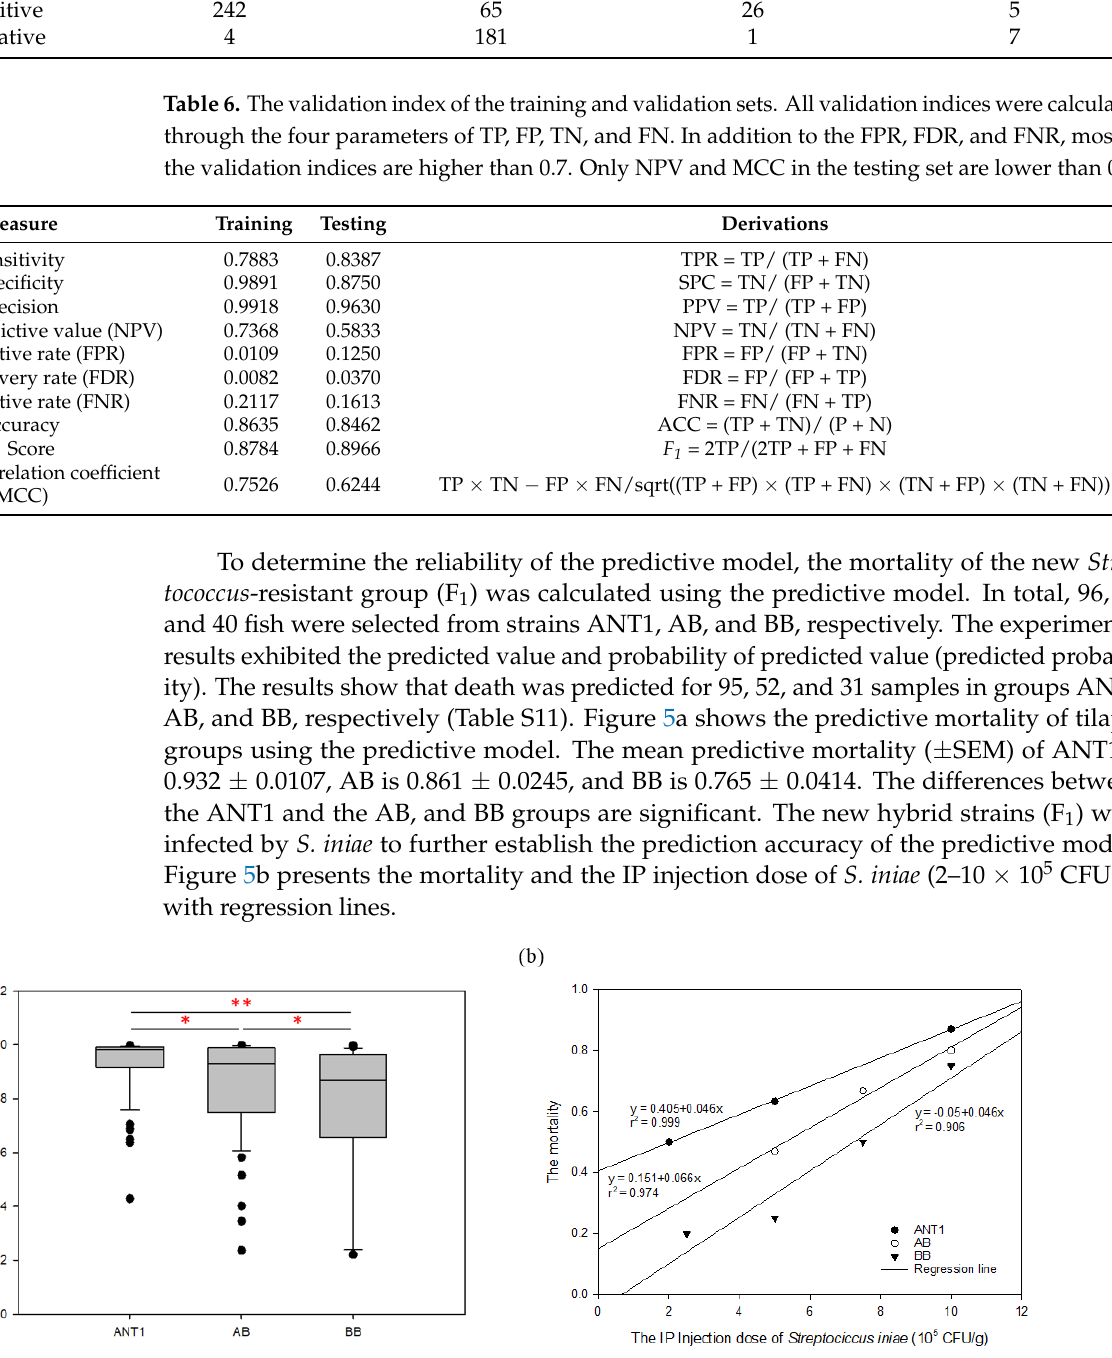
Figure 5. The predictive and actual mortality of new Streptococcus ‐ resistant groups (F 1 ): ( a ) the predictive mortality of tilapia groups via the SVM predictive model. The x ‐ axis denotes different groups, i.e., 96 fish in ANT1; 55 fish in AB; and 40 fish in the BB group. The y ‐ axis is the predictive mortality via the SVM predictive model; 1.0 denotes 100% mortality. The gray box represents the interquartile range (IQR); from top to bottom are upper quartile (Q3), median (Q2), and lower quar ‐ tile (Q1), respectively. The upper line is maximum and the lower line is minimum; dark points de ‐